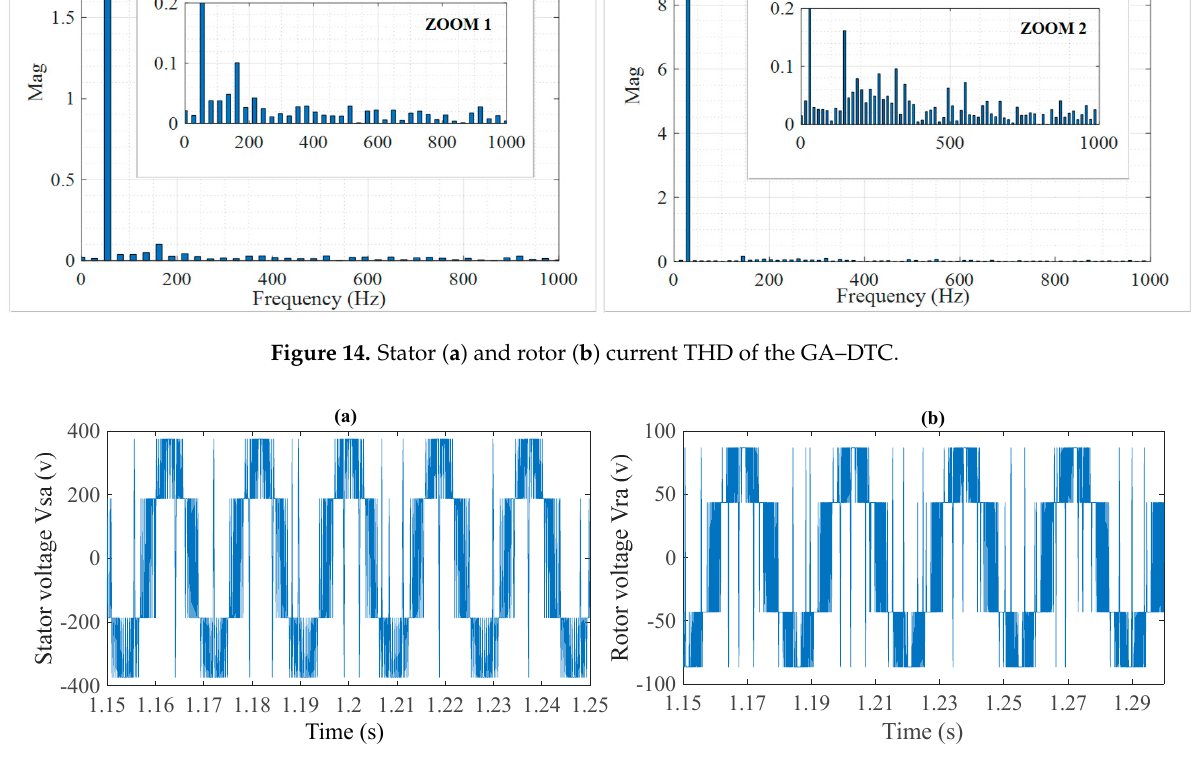
Figure 16. Stator ( a ) and rotor ( b ) fluxes of both strategies . When opposed to a classic DTC, the DFIM with GA–DTC reaches its reference torque value in a far shorter amount of time. Furthermore, the torque is carefully regu- lated in cases where the load fluctuates significantly. In terms of response time, as seen in Figure 7, the proposed DTC based on GA provides a satisfactory response in terms of speed, attaining the target speed with minimal response time and without overshoot. Furthermore, in the case of a rapid change in load, the speed can be managed slowly. Finally, based on the results of the entire study, the suggested method outperforms the classic DTC. Motor control with low torque ripples may be achieved by using the approach suggested in this paper. With respect to the previously stated assumptions, as well as the various perfor- mances presented in Table 4, the GA–DTC proposed in this article achieves its stated goal by showing its resilience and robustness to speed, fluxes, and torque ripples, as well as currents and THDs. The DTC enhanced by using GA allows the DFIM to be controlled more reliably under a wider range of operating conditions than previously possible. Due to the fact that the GA–DTC method adjusts to the machine’s parametric fluctuation, it is supposed to be an optimal solution for variable-speed drive applications, as shown above. Table 4. Performance measures of classic DTC and GA–DTC . Performances